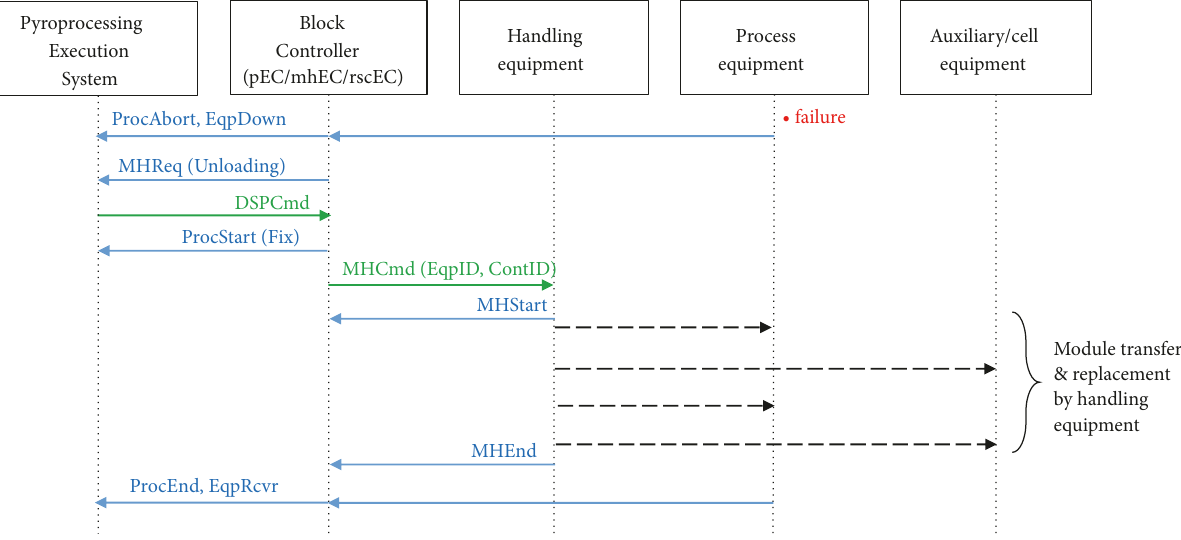
Figure 8: Simplified sequence diagram for automated maintenance